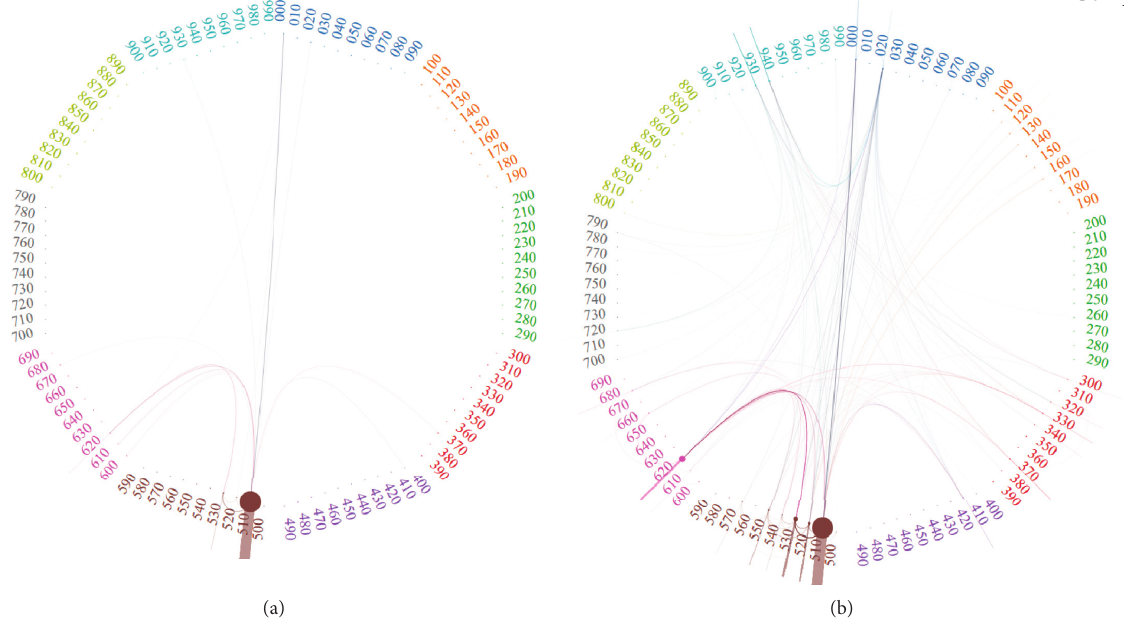
Figure 6: Visualization (by means of PolyViz [73]) of the TTN of the 1 st orbit (a) and of the 2 nd orbit (b) of the German Wikipedia article Integralrechnung ( Integral ). The TTNs are derived from the corpora of articles in the 1 st and the 2 nd orbit (see formula (30)) of this article. Obviously, the most prominent 2 nd level DDC class in both TTNs is 510 ( Mathematics ).